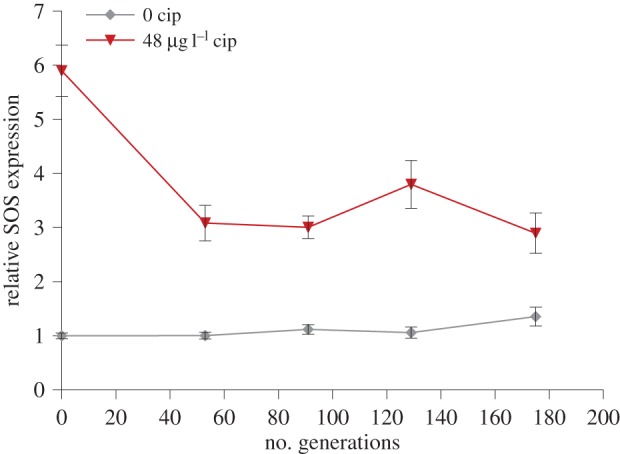
The evolution of SOS response expression. Plotted points show the mean (±s.e.m; n = 16) relative expression of a bioluminescent SOS reporter construct in populations of WTpLex : Lux that were allowed to evolve in culture medium lacking ciprofloxacin (grey diamonds) or containing ciprofloxacin (red triangles). We measured the expression of populations under the conditions in which they evolved.